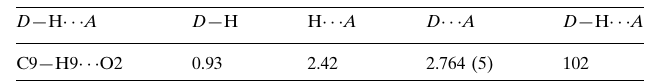
Hydrogen-bond geometry (A˚ , (cid:4)